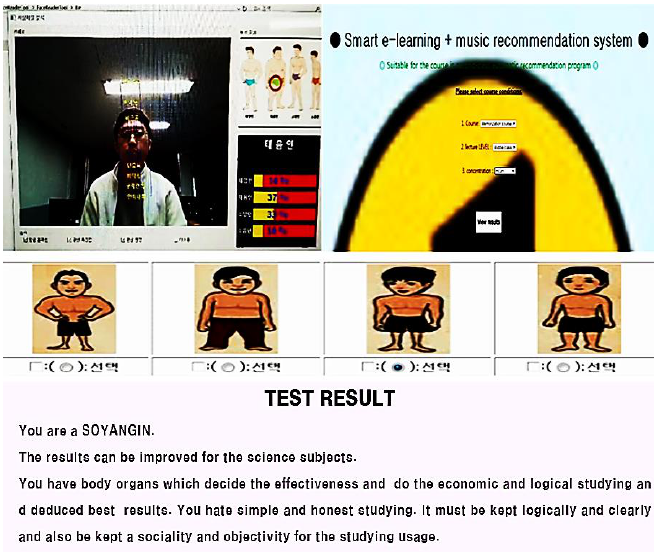
Figure 9. Computer simulation of automatic recommendation of study method.